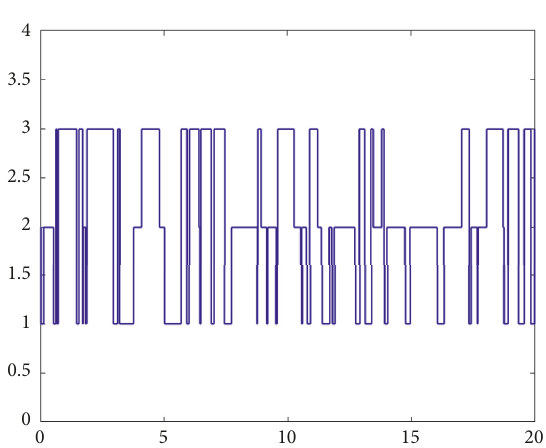
Figure 6: The Markovian switching signals.